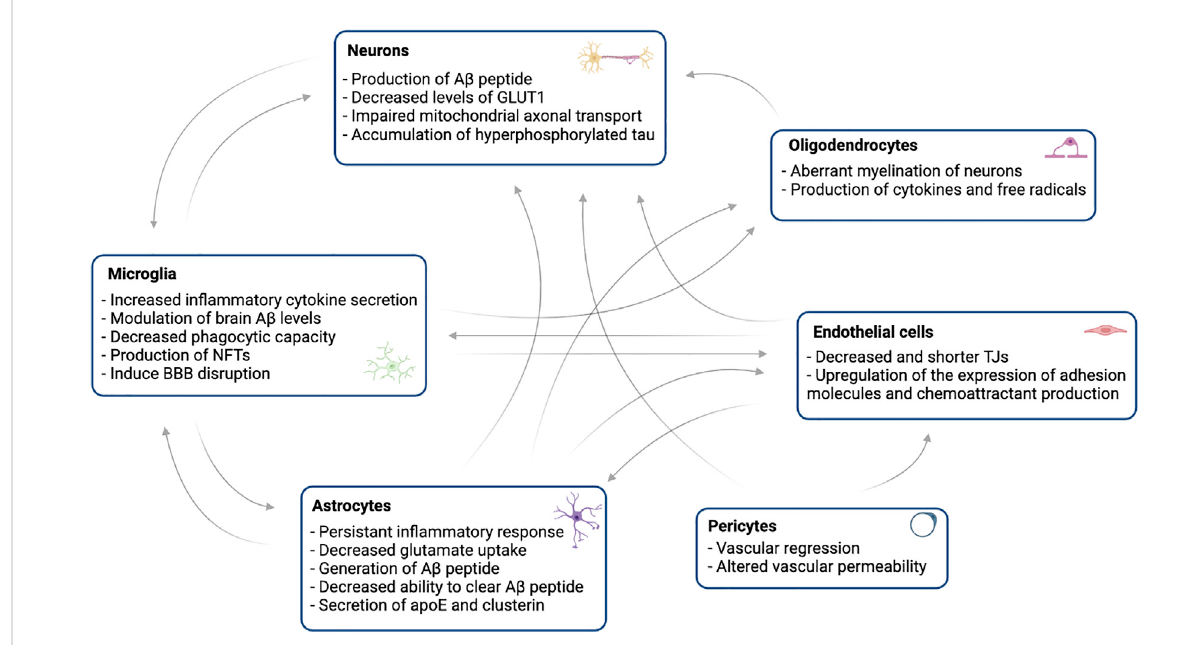
FIGURE 3 SchematicofthebraincellsinteractionsasearlychangesinAlzheimer ’ sdisease(AD).Tosustainbrainfunction, allcelltypesinthebraininteract in a complex network. Many of these homeostatic functions are compromised in the early stages of AD, and pathways involving different cell types damage synapses and neurons. Impairment in endothelial cells, astrocytic endfeet and pericytes, and the accumulation of A β in the vessel walls triggers vascular integrity disruption. These vascular alterations result in impaired vascular protein clearance, hypoperfusion, and BBB disintegration. Amyloid plaques are surrounded by astrocytes and microglia, which initially contribute to remove amyloid protein but become reactive and release cytokines after being exposed to A β . In AD, tau accumulates within neurons as neuro fi brillary tangles (NFTs), which are linkedto glial accumulation, neuronal dysfunction and death. Chronic hypoperfusion compromises white matter integrity by causing oligodendrocyte loss and myelin